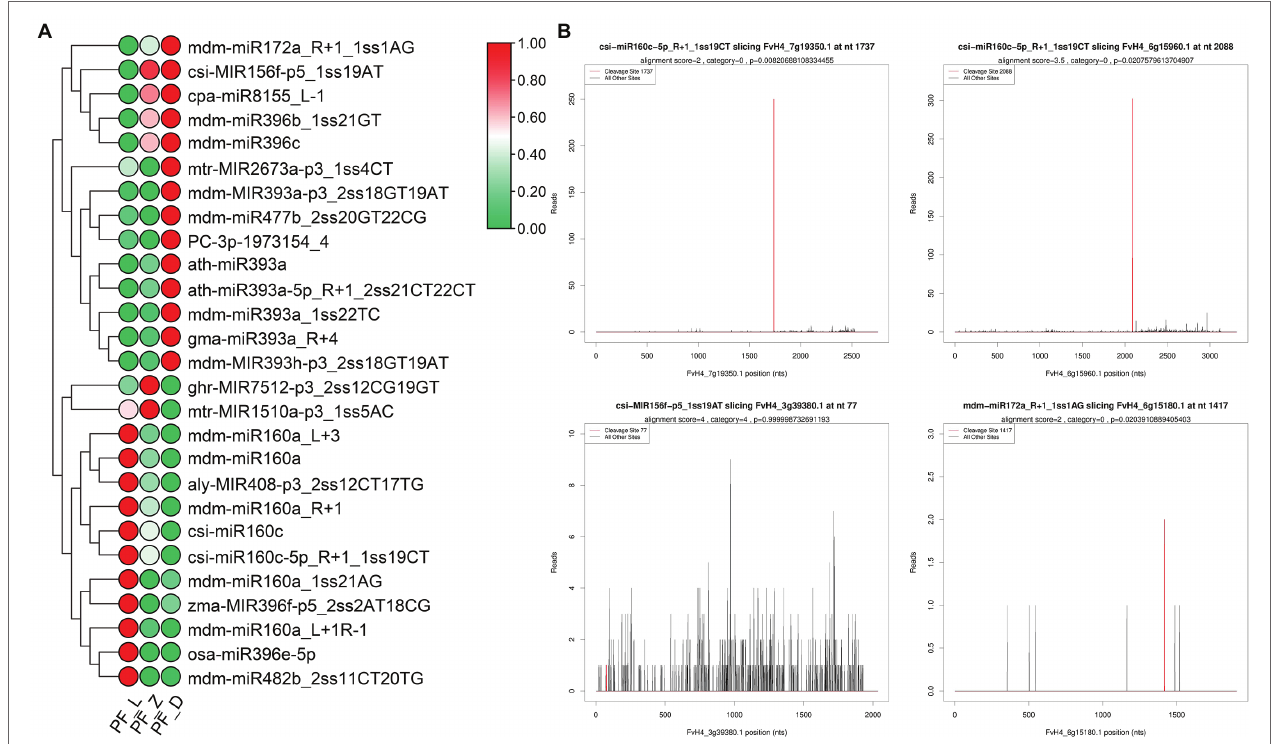
FIGURE 6 | Differently expressed miRNAs involved in hormone signal transduction pathway and target (T) plots of miRNAs verified by degradome sequencing. (A) Heatmaps showing expression patterns of the different expression miRNAs involved in hormone signal transduction pathway. (B) T plots of the targets cleaved by the corresponding miRNAs from the degradome library. The redline represents the predicted cleavage site of the corresponding